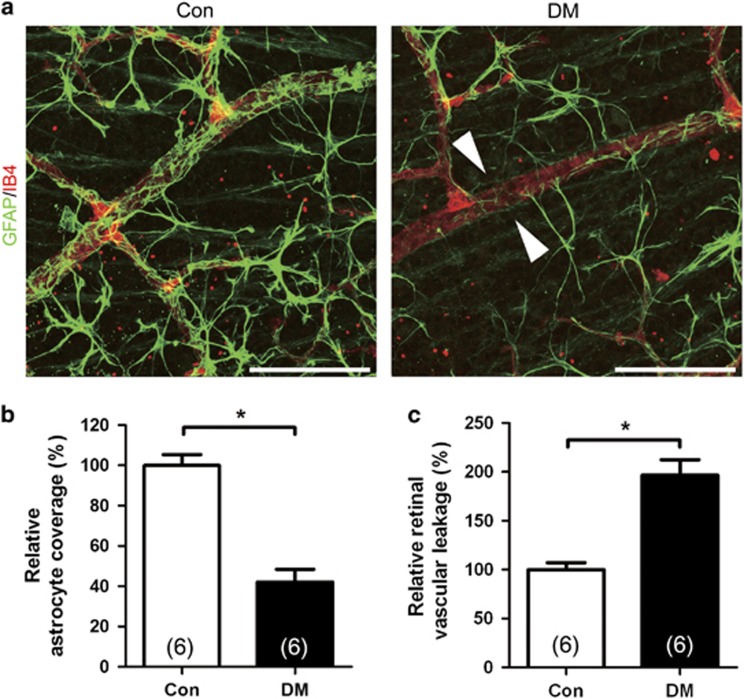
Retinal astrocyte loss occurs with retinal vascular leakage in early diabetic mice. Retinal vascular leakage and distribution of astrocyte were evaluated in 3-week streptozotocin-induced diabetic mice (DM) and age-matched controls (Con). (a) Representative site of focal astrocyte loss in mid-peripheral retina is shown in diabetic retina (original magnification × 400; scale bar, 100 μm). White arrowheads indicate loss of astrocytes on diabetic retinal vessels. (b) Relative astrocyte coverage (colocalized area of astrocyte and vessel/vascular area) is shown and normalized to the value of control mice. (c) Retinal vascular leakage with FITC-dextran (70 kD) is evaluated and relative retinal vascular leakage (%) of diabetic retina is shown normalized to the value of control mice. The sample size for each group is indicated on the bar graph. The bar graphs represent mean±S.E.M.; *P<0.01 by Student's t-test